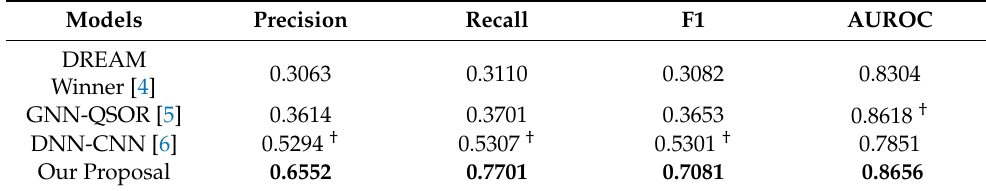
Table 1. Comparison of odor descriptor prediction results with other models. The best values for each metric are in bold, while the second best values for each metric are marked with “†”.